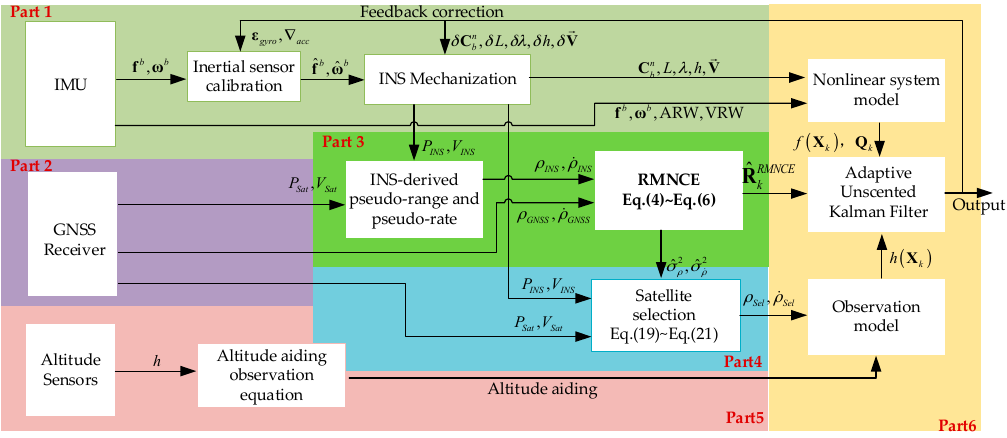
Figure 3. The proposed tightly-coupled architecture based on the RMNCE approach.